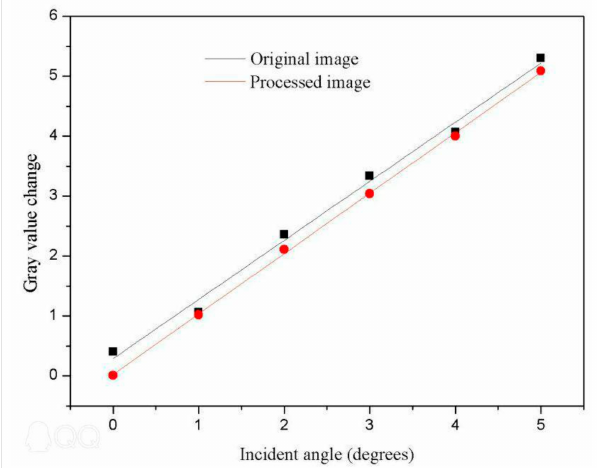
Figure 14. Relationship between the gray value of a PSi microcavity surface image and the laser incidence